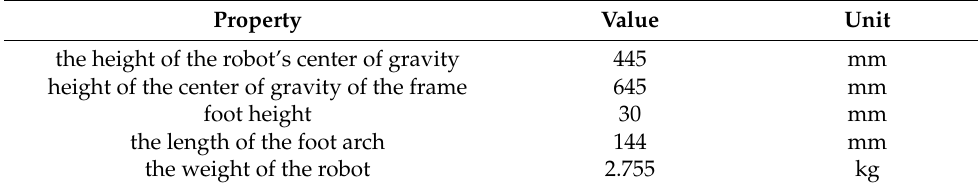
Table 4. Parameters of the three-dimensional model. Property Value Unit the height of the robot’s center of gravity 445 mm height of the center of gravity of the frame 645 mm foot height 30 mm the length of the foot arch 144 mm the weight of the robot 2.755 kg